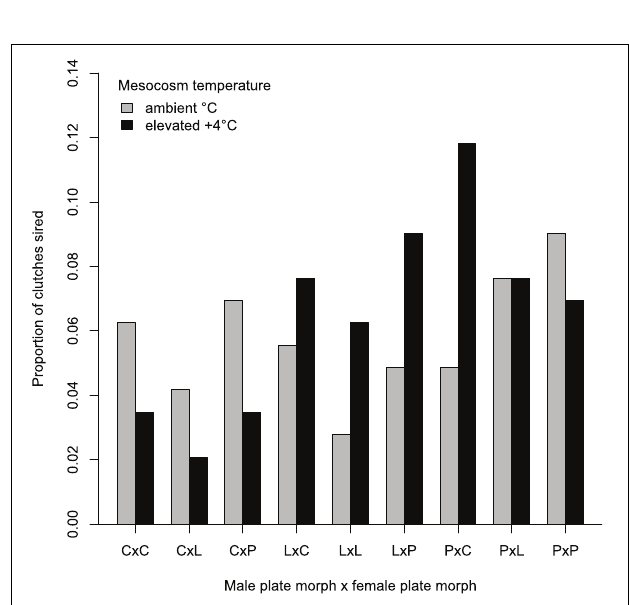
FIGURE 3 | Clutch siring success (measured as the proportion of clutches sired) for each male plate morph in combination with female plate morphs (c, complete; l, low; p, partially plated) in ambient and elevated (+4 ◦ C) temperature mesocosms.